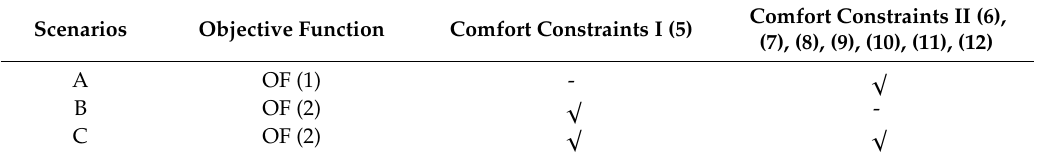
Table 1. Comparison of 3 scenarios based on their